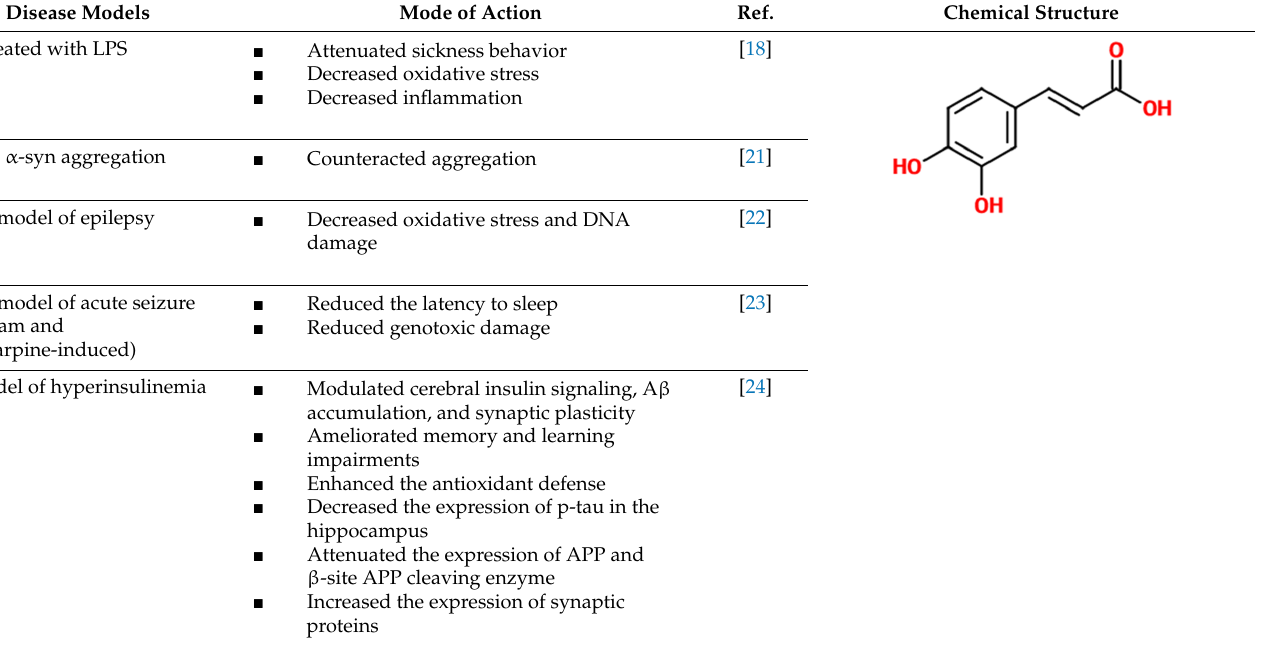
Table 1. Phenolic acids and related characteristics.